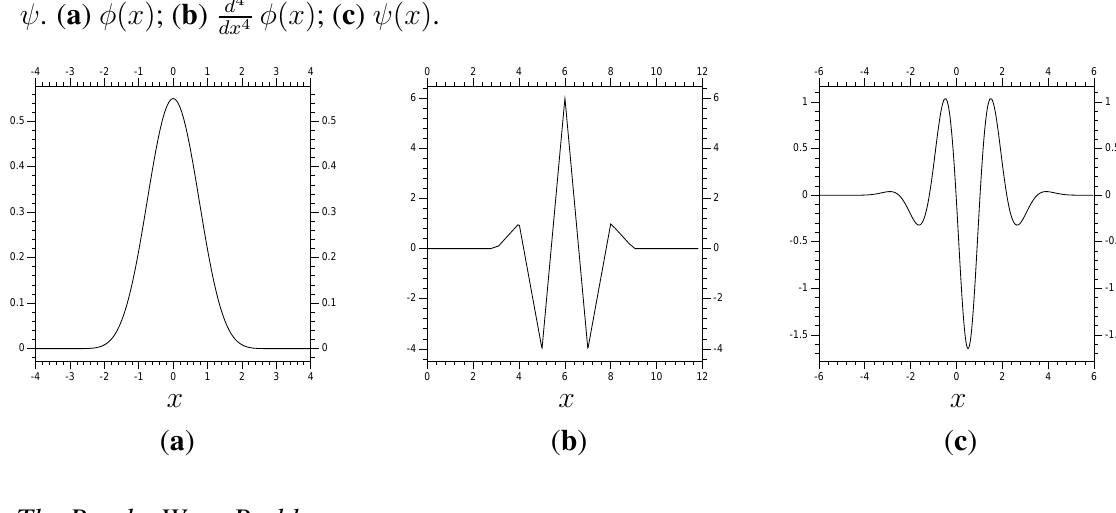
= ϕ , our scaling function. Next, d 4 5